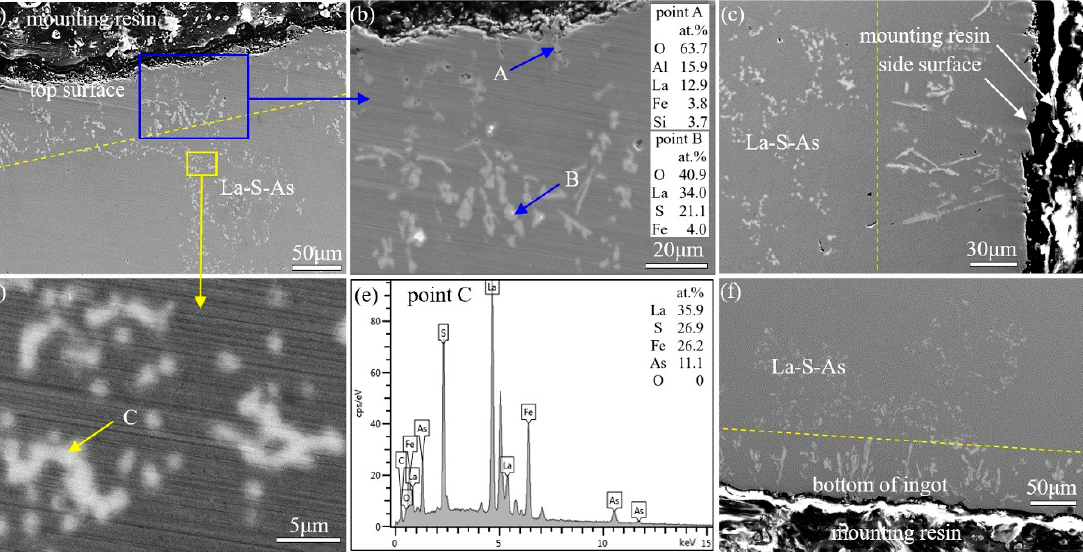
Figure 4. Morphologies, distribution, and compositions of inclusions on the profile of the ingot (backscattered electron images). ( a ) Top surface of the ingot; ( b ) an enlarged image of La 2 O 2 S and LaAlO 3 inclusions; ( c ) side surface of the ingot; ( d ) an enlarged image of La–S–As inclusions near the top surface; ( e ) energy dispersive spectrum (EDS) of point C; ( f ) bottom of the ingot.